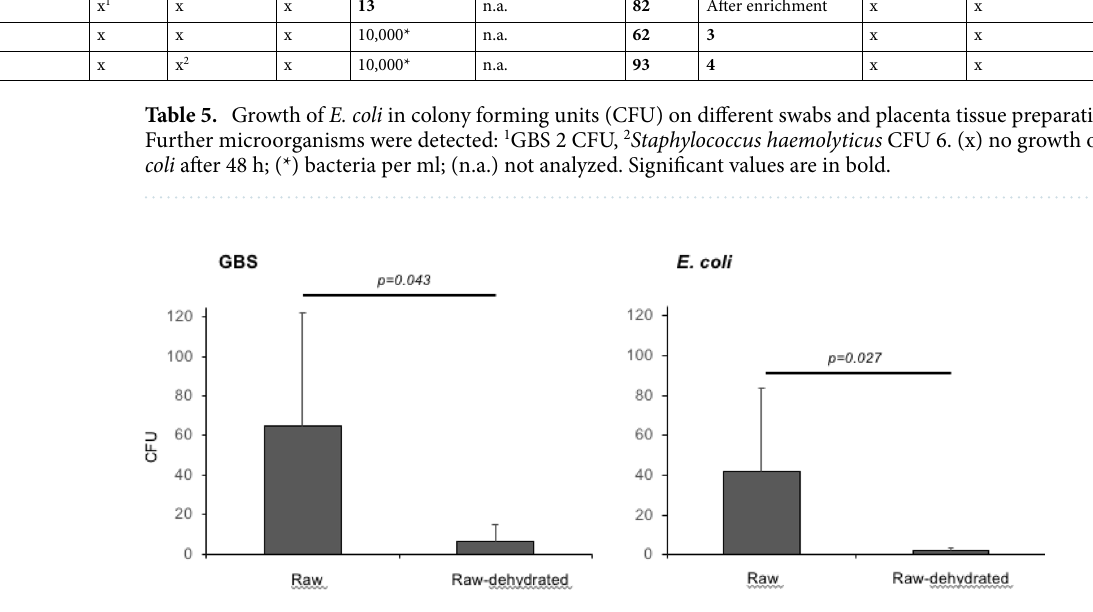
Figure 2. Number of CFU (mean ± SD) from raw and raw-dehydrated placenta samples after artificial inoculation (surface and injection samples merged) with GBS or E. coli . Raw preparation includes rinsing placenta under cold running water and homogenizing the tissue. Raw-dehydrated tissue was heated to 55 °C for 8